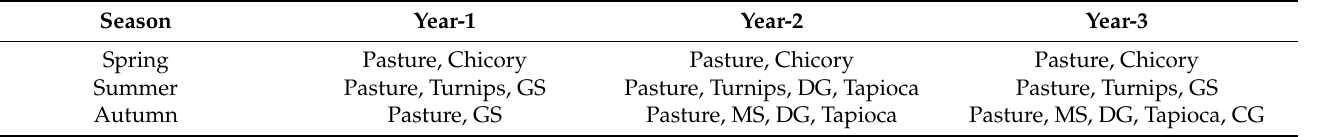
Table 1. Seasonal feeding regimes for grazing dairy cows during the study